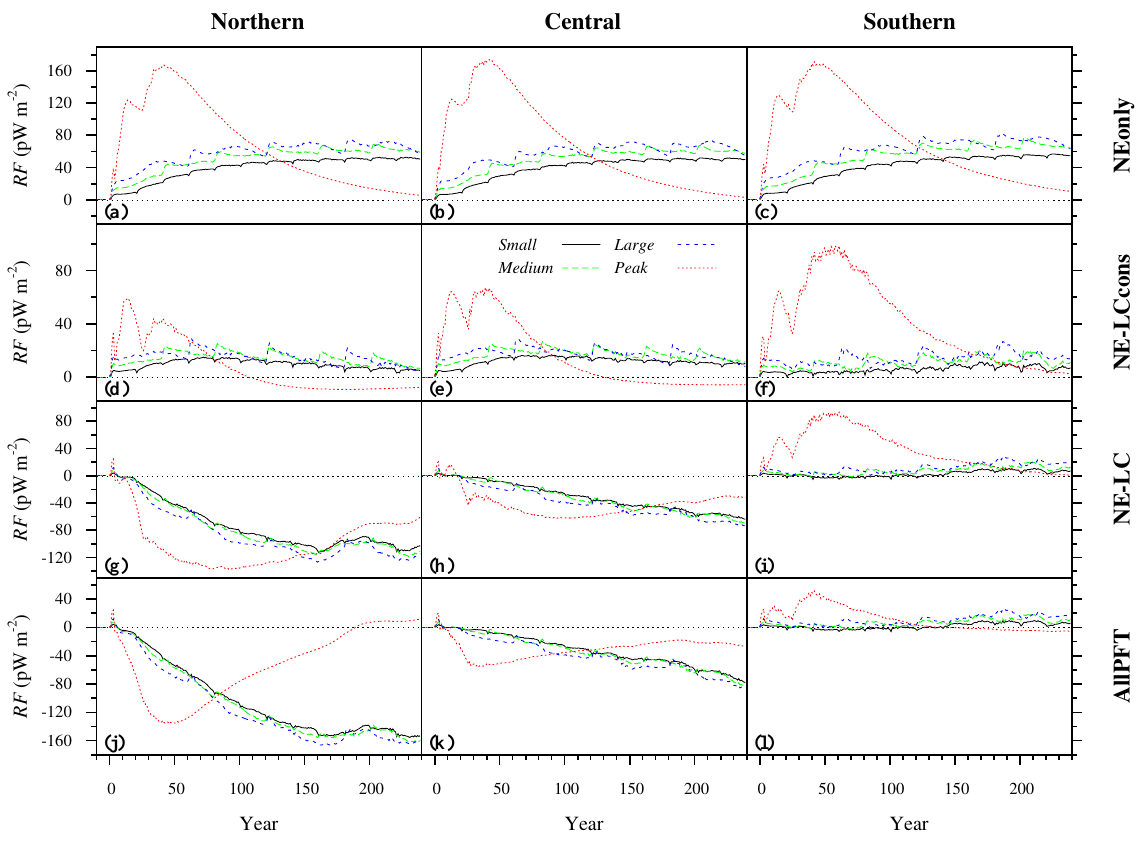
Figure 5. Transient effect of the different MPB outbreak regimes on radiative forcing (RF; in pico-Wm − 2 , for 1ha outbreaks) compared with the no-outbreak control (first outbreak occurred in year 1). The columns correspond to the three locations (Fig. 1) and the rows to the four vegetation coexistence scenarios (Table 2); the y axis scale differs across the four